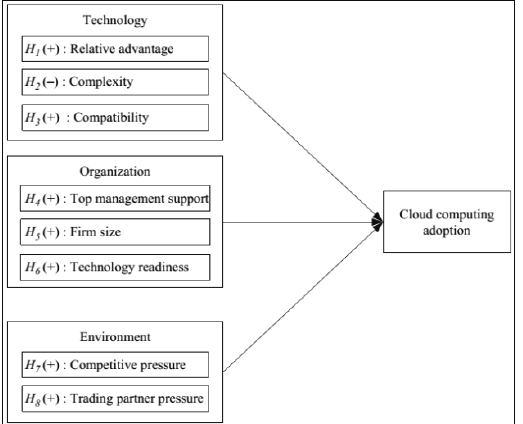
Fig.4. Conceptual Model for adoption of